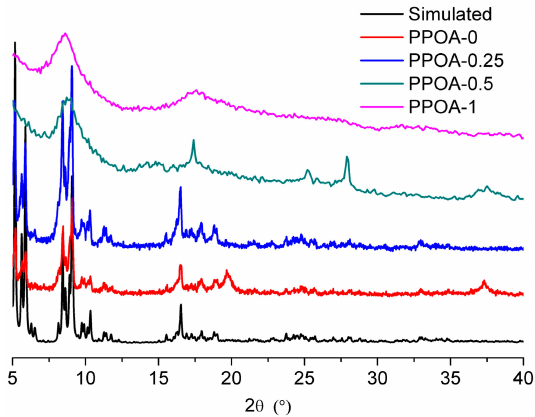
Figure 1. The XRD patterns of PPOA-0, PPOA-0.25, PPOA-0.5, and PPOA-1 samples with simulated patterns of MIL-101(Cr) (CSD-refcodes: OCUNAK)